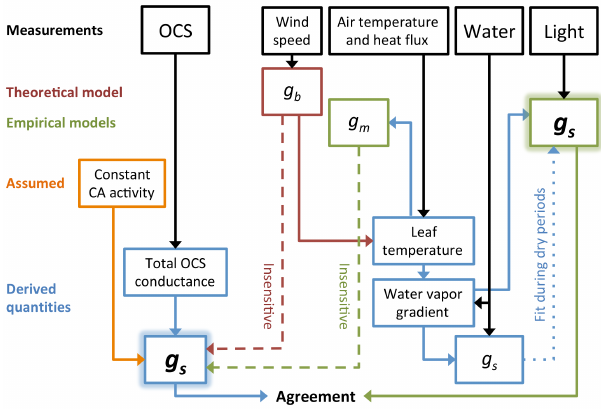
Figure 1. Flowchart of the OCS- and water-flux methods for es- timating stomatal conductance. Note that the assumed CA activity and the empirical models for g b , g m , and g s also depend on leaf area index (not shown).